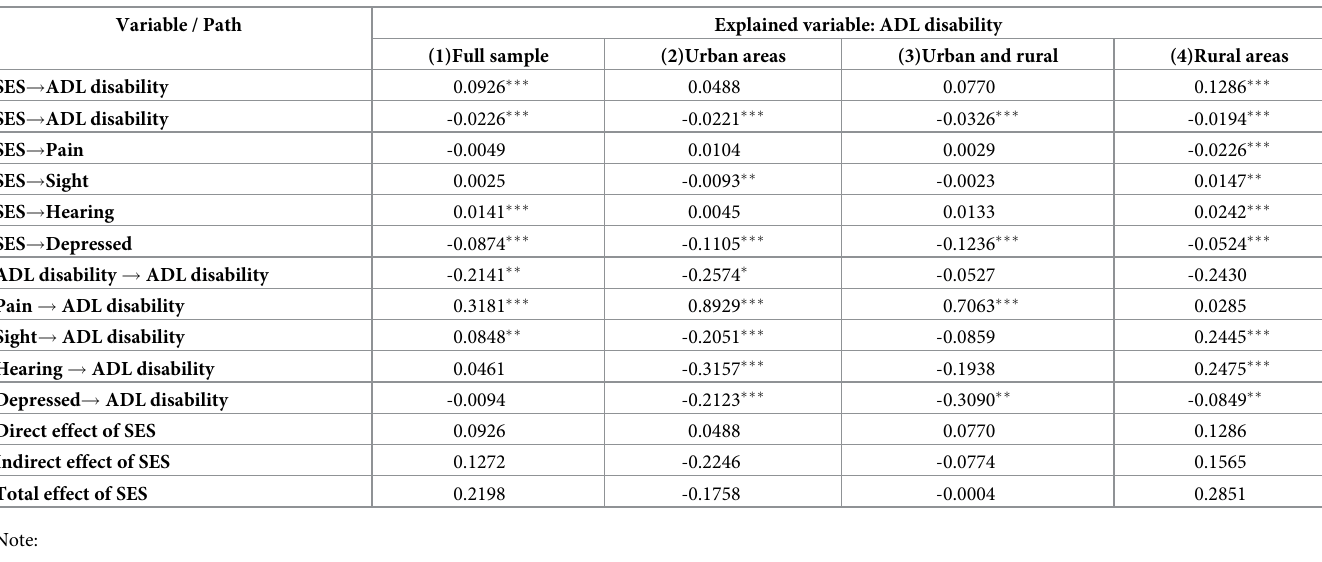
Table 5. Path results of SES influencing ADL disability in the older adults.